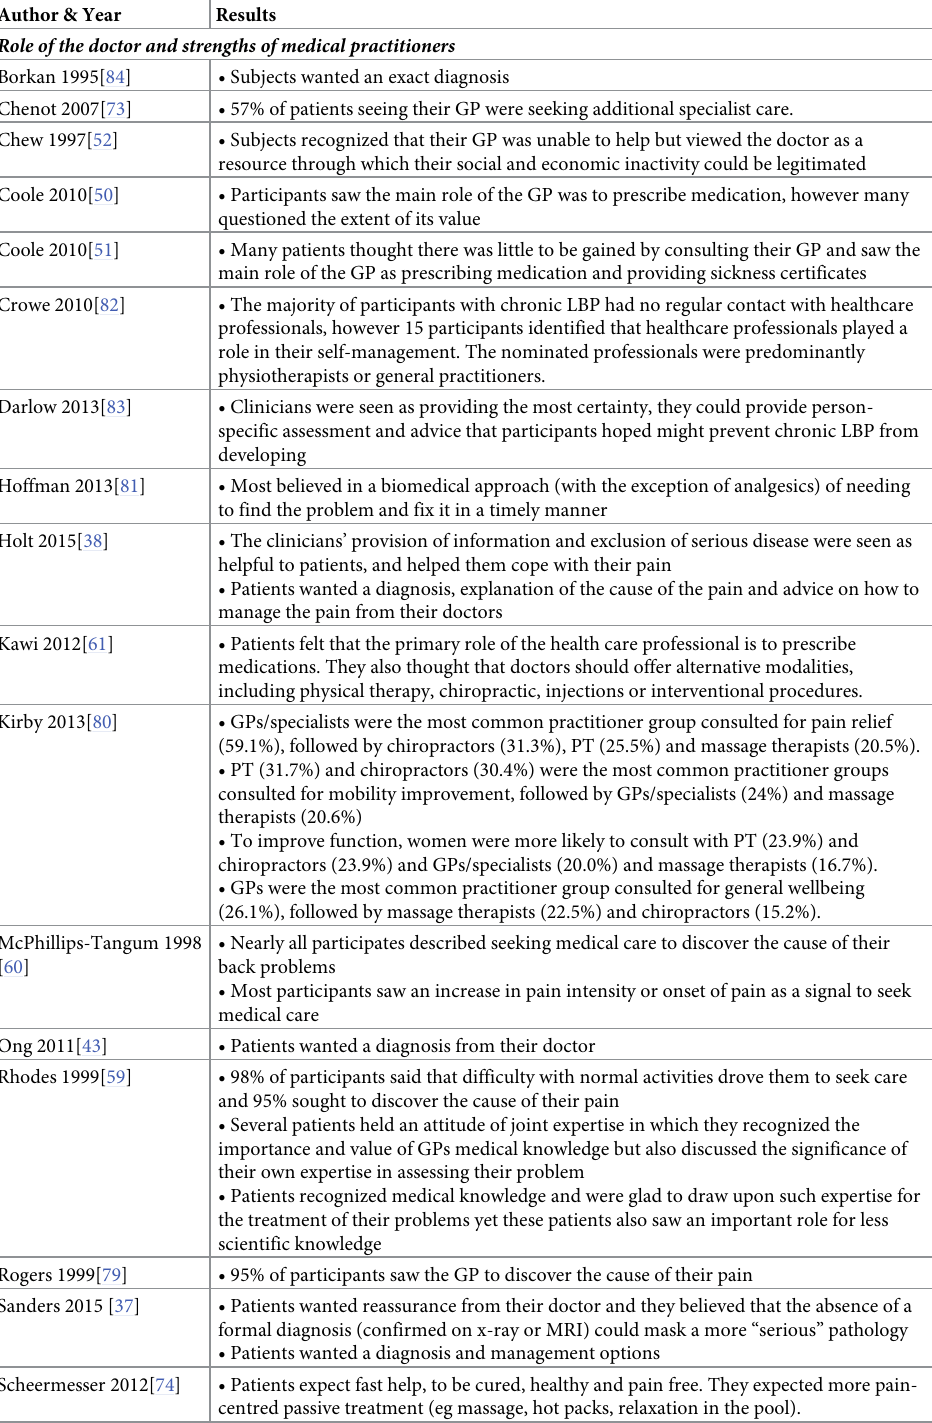
Table 2. The perceived need for medical